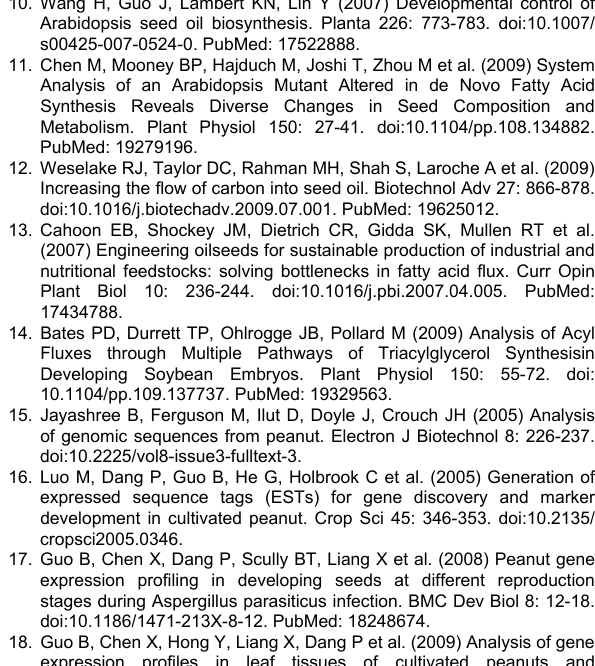
Table S7. Peanut Unigenes in fatty acid biosynthesis and elongation pathway.